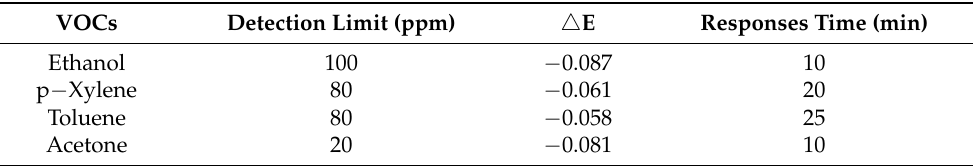
Figure 5. Extinction changes of the WO 3 /SnO 2 /Ag/PMMA sensing materials exposed to various concentrations of ( a ) ethanol, ( b ) p − Xylene, ( c ) toluene, and ( d ) acetone. Table 2. Detection limit and response time of the WO 3 /SnO 2 /Ag/PMMA sensing materials when exposed to various VOCs